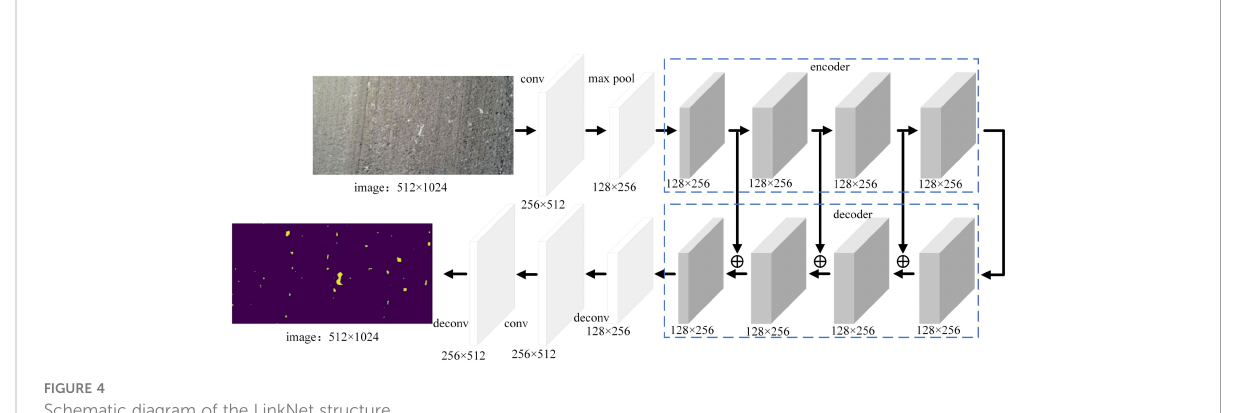
FIGURE 4 Schematic diagram of the LinkNet structure.